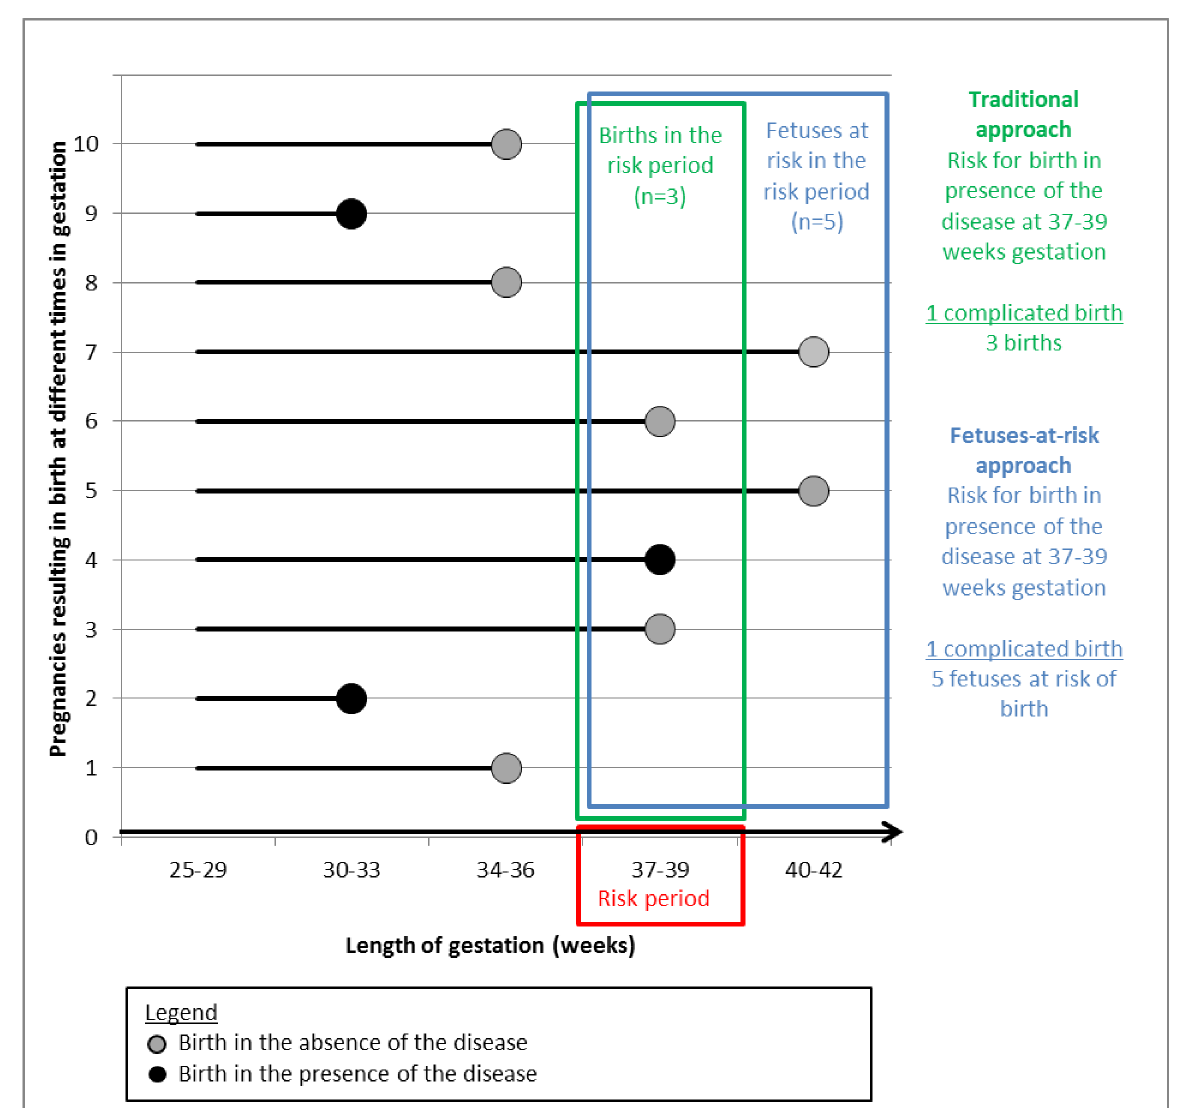
Fig 1. Schematic depiction of pregnancy course and options for calculating the gestational age-specific disease rate in 10 hypothetical pregnancies. Traditional approach : Number of affected births in a gestational group divided by the number of total births within that gestation group = 1/3. Fetuses at risk approach : Number of affected births at gestational group divided by the number of fetuses at risk for a disease at that gestation group = 1/5. Modified after Joseph et al(24).